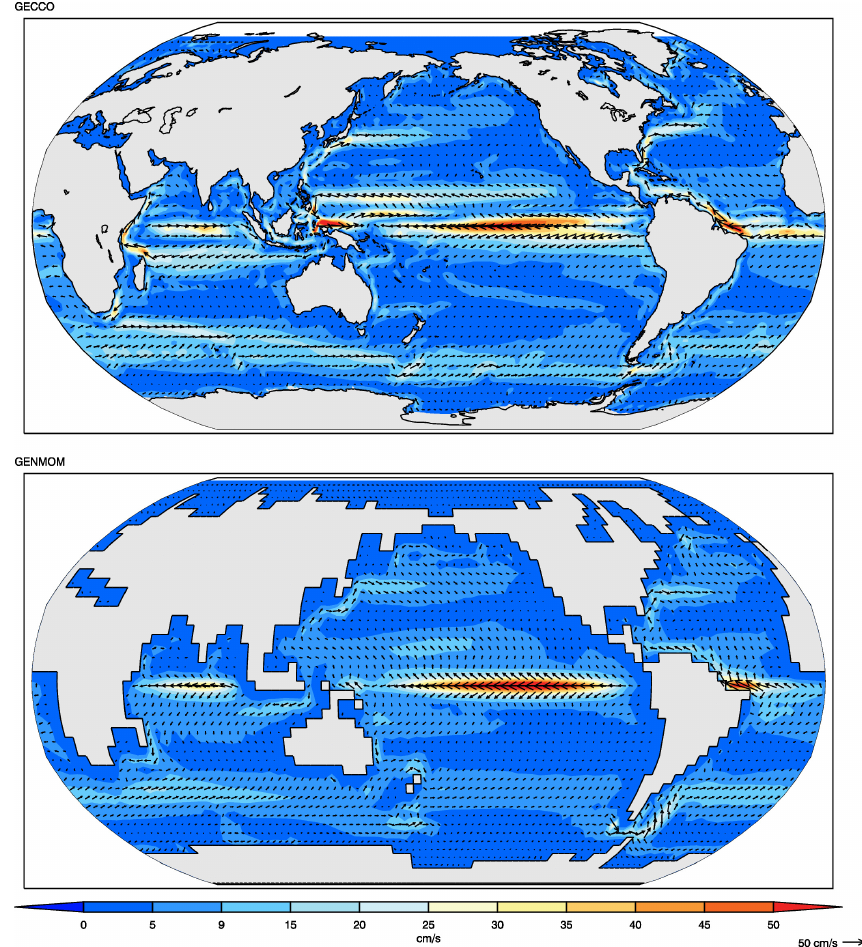
Fig. 10. Annual global surface currents for both observations (GECCO) and GENMOM